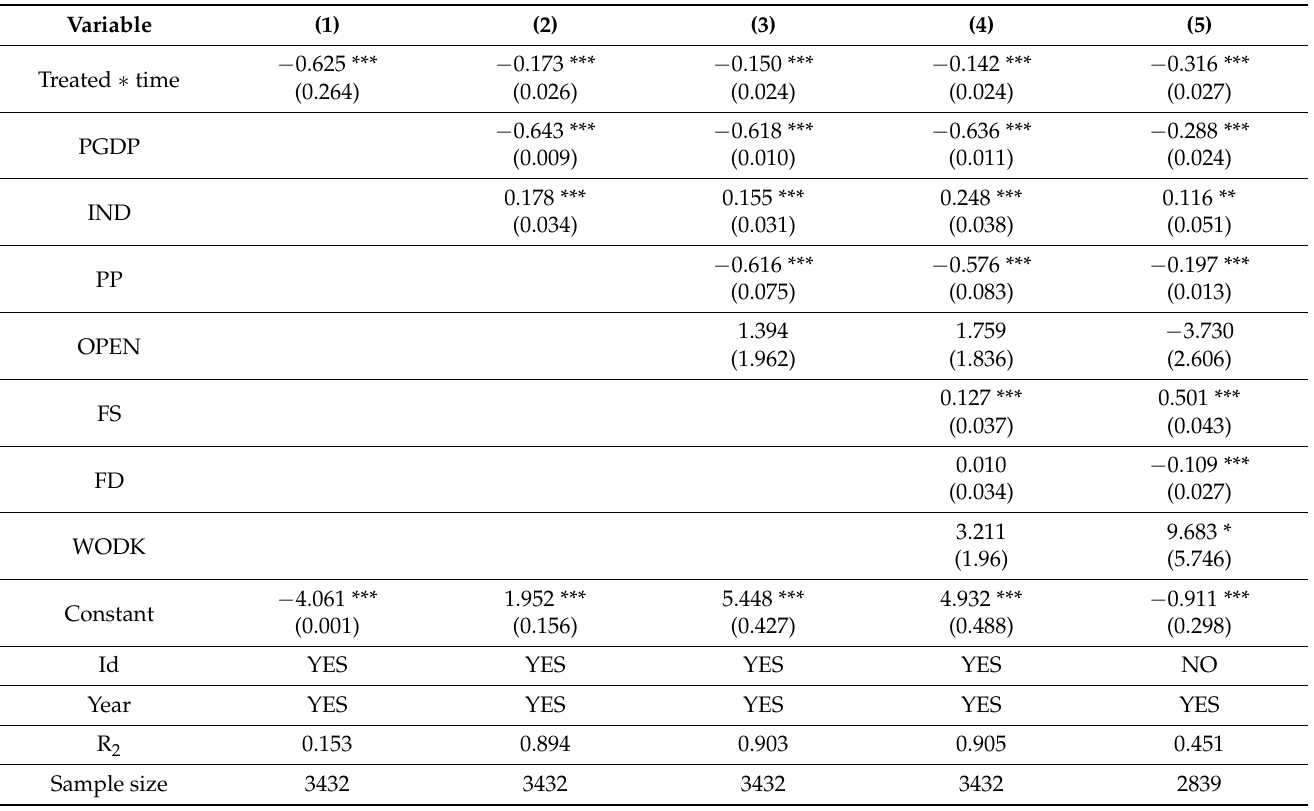
Table 4. Dual difference